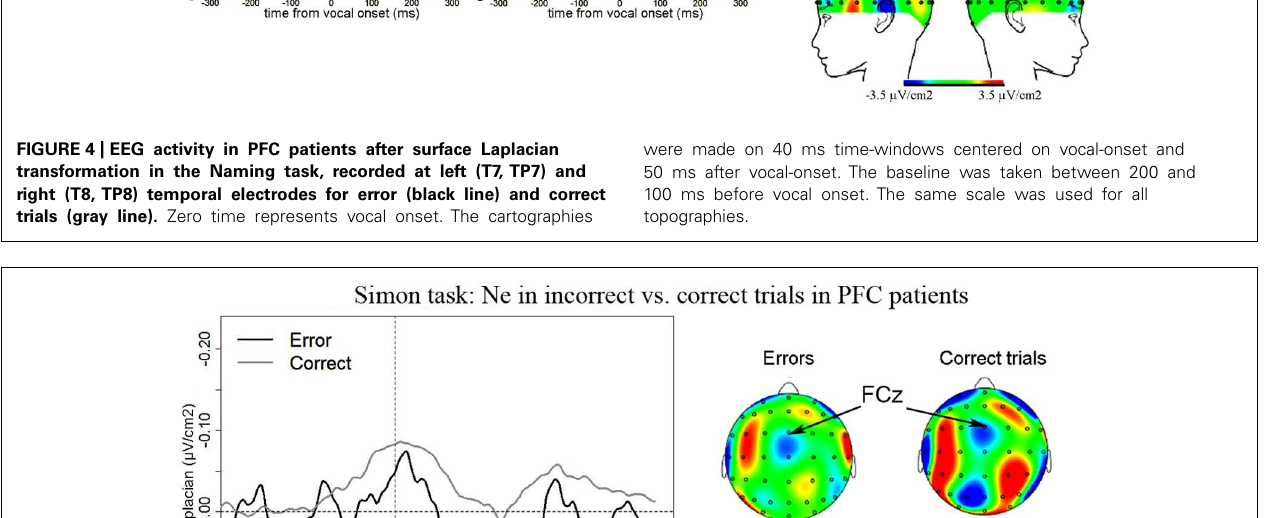
were made on 40 ms time-windows centered on vocal-onset and 50 ms after vocal-onset. The baseline was taken between 200 and 100 ms before vocal onset. The same scale was used for all topographies.